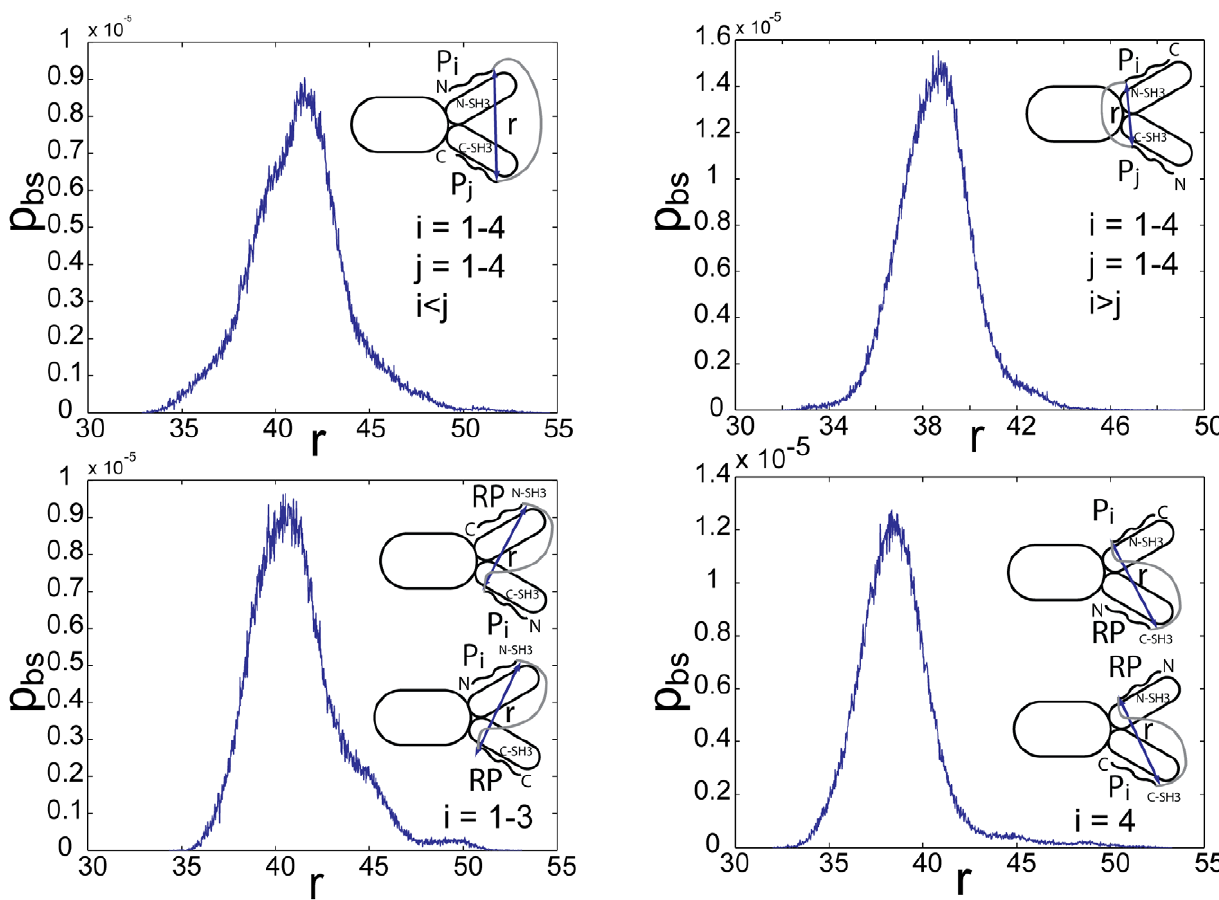
Figure 6. The probability density for distance between binding sites ( p bs ( r ) ) in Sos1 bound to Grb2. Depending on the P i and P j motifs bound to Grb2, one of four different probability distributions are used (explained in inset of figures).